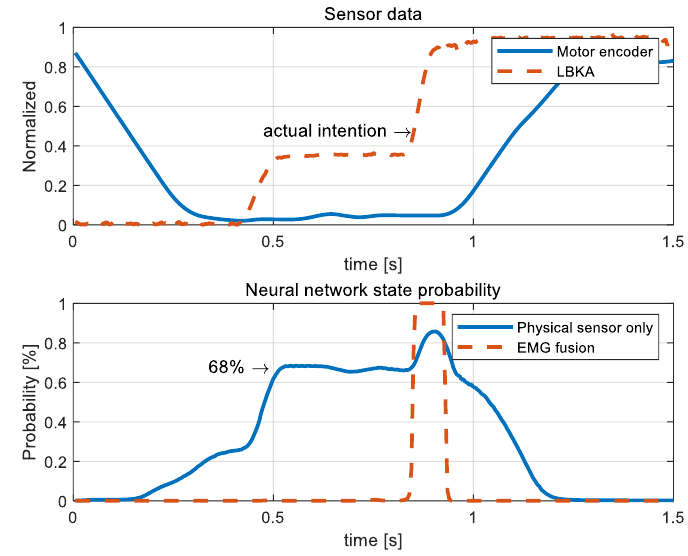
Figure 11. A graph of the measured sensor values and NN results. The probability of the NN with the physical sensor only was calculated as high even when there was no actual intention, whereas that of the NN with EMG fusion was calculated as high only when there was the actual intention.